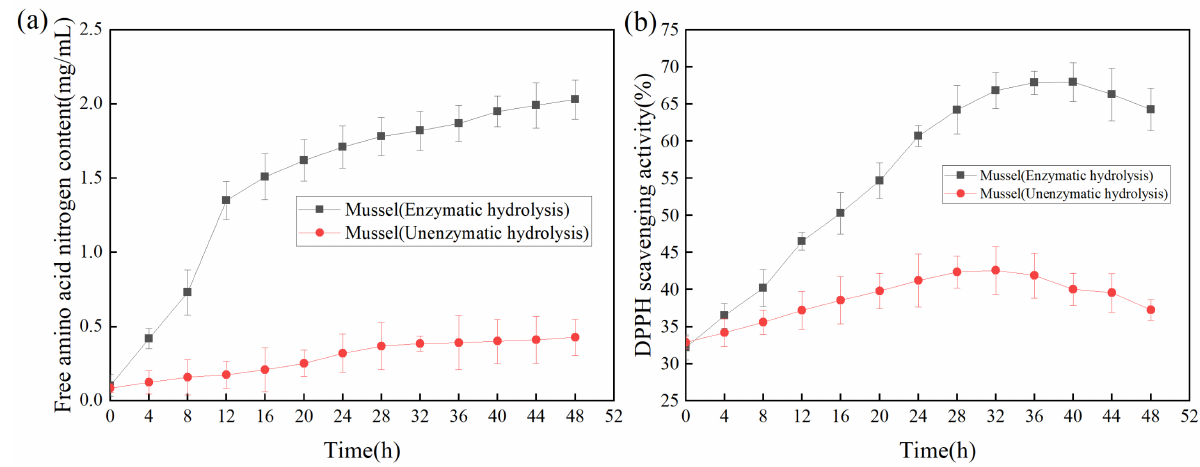
Figure 6. ( a ) Effect of enzymolysis time on free amino acid nitrogen; ( b )Effect of enzymolysis time on DPPH scavenging